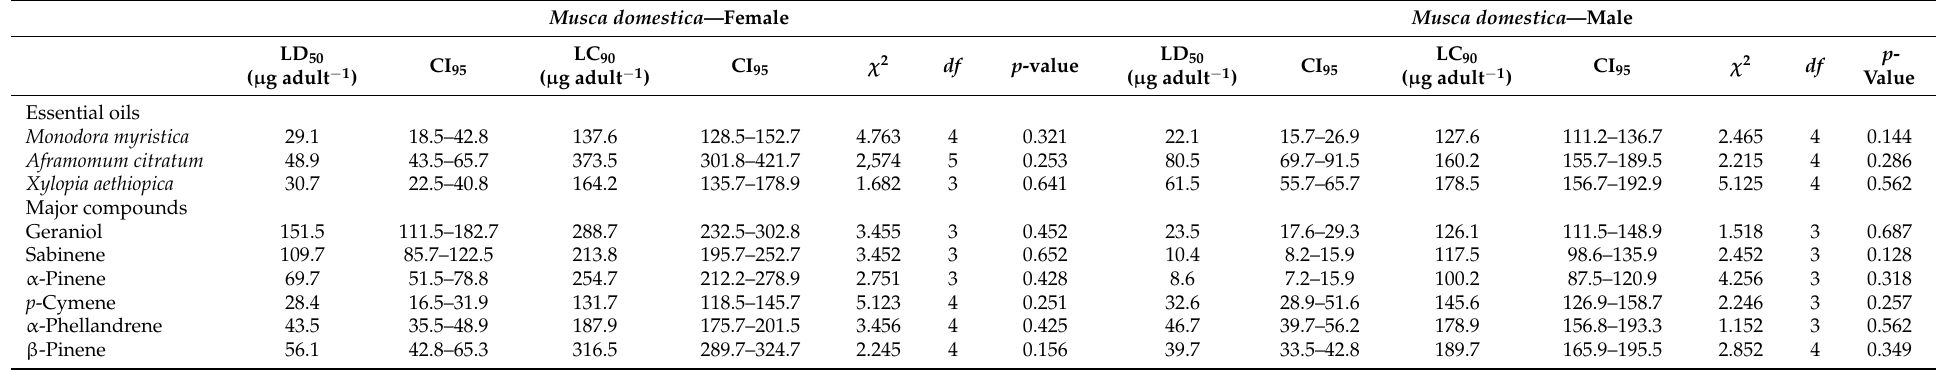
Table 2. Insecticidal activity of Monodora myristica , Aframomum citratum , and Xylopia aethiopica seed essential oils and their major constituents on Musca domestica